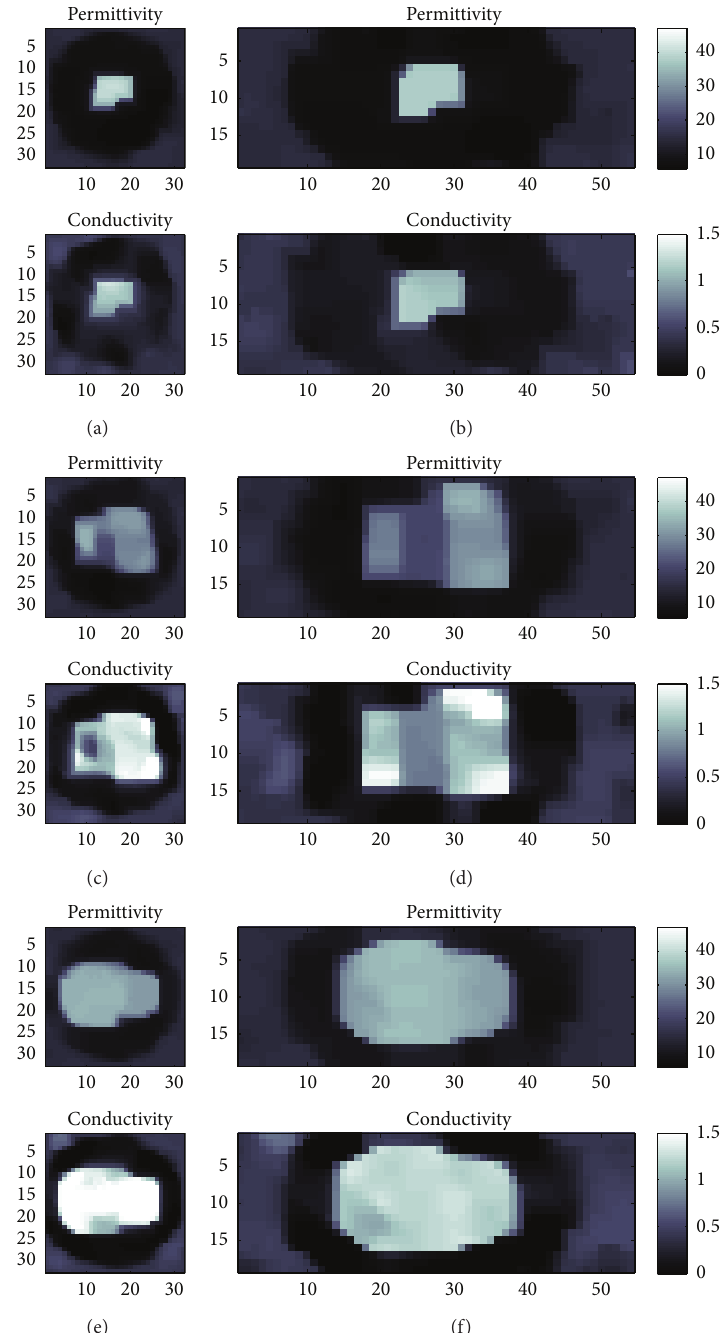
Figure 8: Reconstructions for the different phantoms for an SNR of 10 dB. (a) (b) Mostly fatty phantom. (c) and (d) Scattered fibroglandular phantom. (e) and (f) Very dense phantom. Left Side: no compression. Right side: with compression.